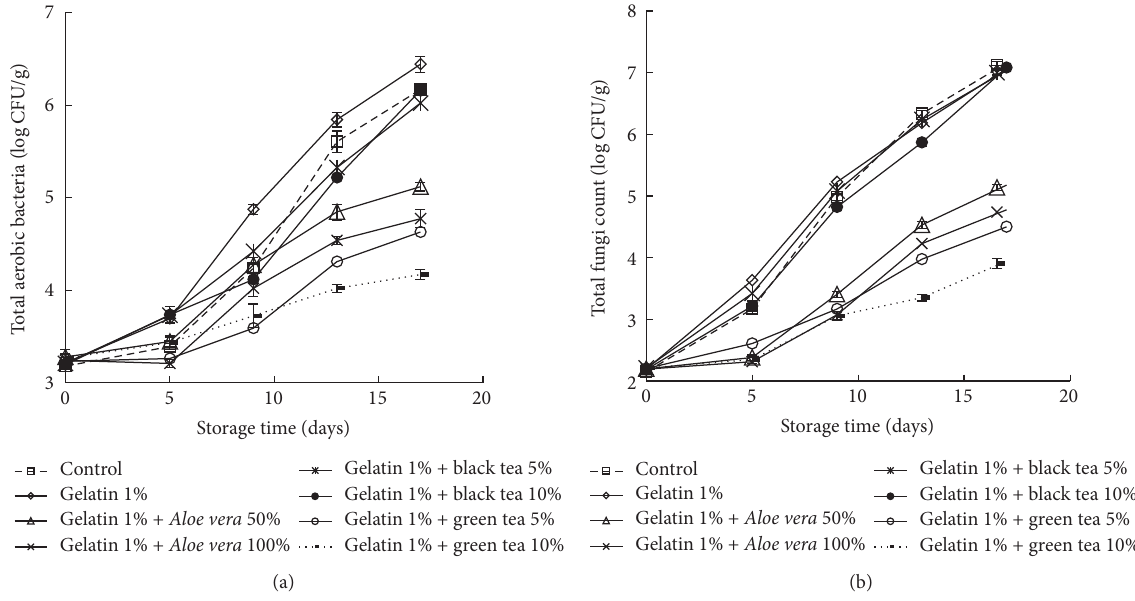
Figure 3: Total aerobic mesophilic bacteria and fungi counts of coated fresh-cut oranges during storage at 4 ∘ C for 17 days. Error bars represent standard deviation between replicates ( 𝑛 = 3